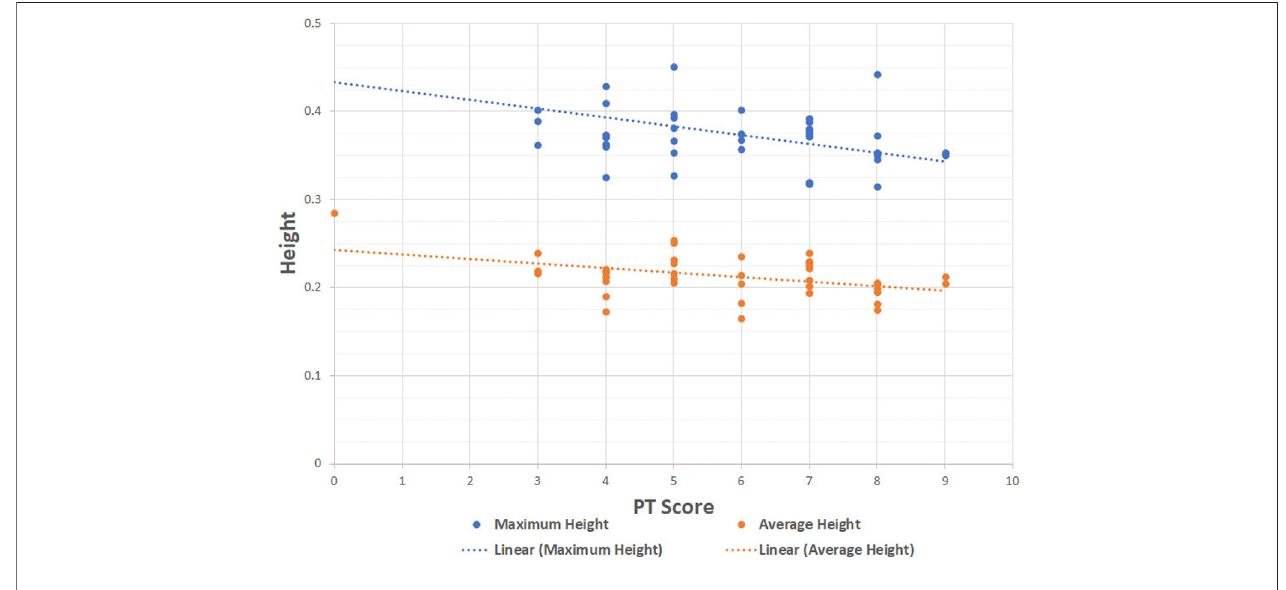
FIGURE 5 | Maximum and average height of hand movement per task, by PT rating.